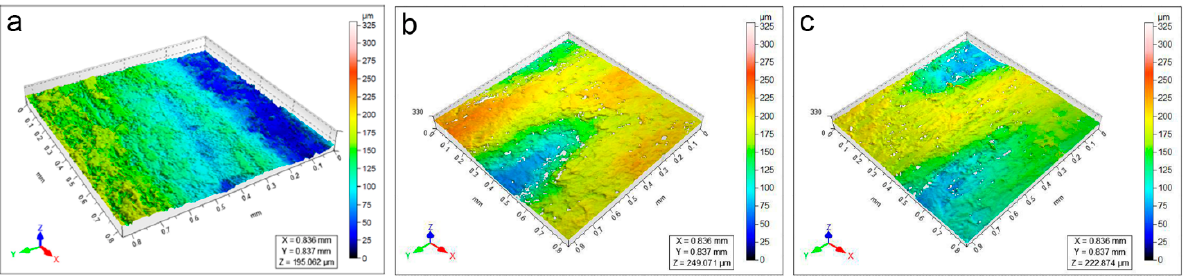
Figure 11. Considered roughness values of Sa ( a ), Ssk ( b ), and Sv ( c ) on the area of EAM and sweat − EAM cleaned by different gels and application time CA_1, CA_3, KGB_1, KGB_3, and Agar_3. 4. Conclusions In this paper, we introduce two biopolymer gels for cleaning, calcium alginate (CA) and konjac glucomannan borax (KGB) gels, loaded with an ecological surfactant for the removal of soiling and sweat deposits from smooth or rough wooden surfaces. These bi- ocompatible products have shown successful performance for artefact conservation, with favourable mechanical properties compared to the traditional Agar rigid-gel. Compressive and tensile tests were performed on both CA and KGB fresh and aged gels to measure the stability of the mechanical properties over time. CA showed sufficient elasticity and mechanical resistance to be applied to and removed easily from the mock- up surface without breaking. Despite the decrease in this property after ageing, CA proved to be still less brittle than Agar, reducing the risk of leaving residues on the surface after cleaning. KGB gel showed the highest softness and elasticity even after 60 days of storage, which is an advantageous aspect for conservation interventions. The texture of this gel is its most distinctive feature, also compared with Agar, which is instead classified as a rigid gel. These desirable mechanical characteristics led CA and KGB gel to be effective in the cleaning of different surfaces, including a smooth varnished surface inspired by classical Western bowed string instruments (WM) and a rough and irregular surface treated with the traditional East Asian Nakdong technique (EAM). The monitoring of the soil deposit removal by XRF, in accordance with the morphological profilometric analysis of the cleaned surfaces, demonstrated that KGB was better at cleaning soil from both smooth and rough surfaces. In the WM, efficiency significantly increased after the second appli- cation of the gel, while in the EAM, effectiveness reaches good levels of cleaning after just one application. CA showed slightly lower efficiency than KGB on soiled-WM, but com- parable on EAM. As for the soiled-WM and -EAM, the control tests performed with Agar revealed results similar to those obtained with CA and KGB, in particular after three